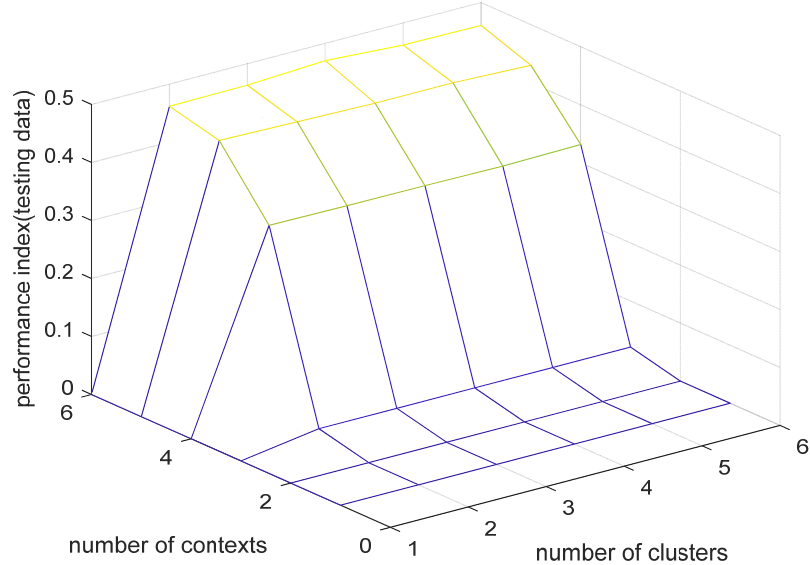
Figure 10. Performance index of the CGK-based fuzzy granular model for testing data (uniform generation of contexts, number of contexts = 6, number of clusters = 4).